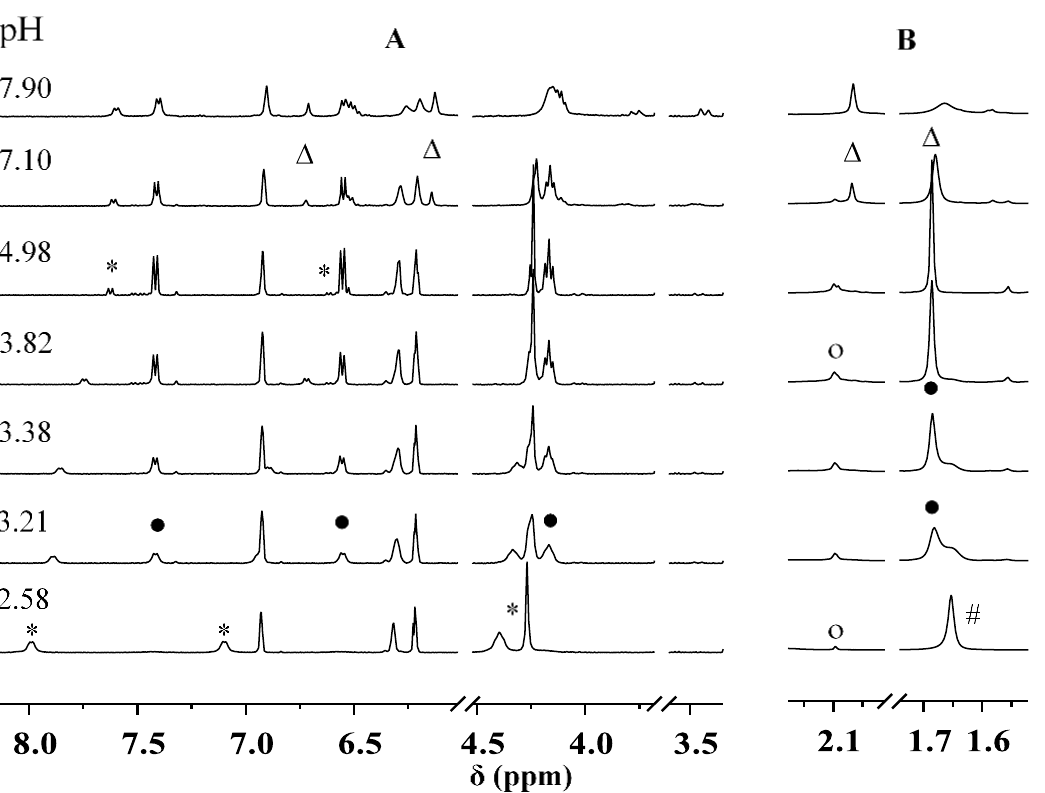
Figure 7. pH-dependence of the signals belonging to the L3 protons ( A ) and Cp* CH 3 protons ( B ) of a 0.95:1 [( η 5 -Cp*)Rh] 2+ –L3 sample, c L3 = 5.0 mM. Symbols represent the signals belonging to the following species: H x (L3) (*), (O,O) coordinated [MHL] 2+ ( • ), (N,N) coordinated [MH 2 L] 3+ or [MHL] 2+ (o), [M] 2+ (#), [M 2 H –1 L] 2+ ( ∆ ). The intensity scales are different for Figures. A and B for clarity.